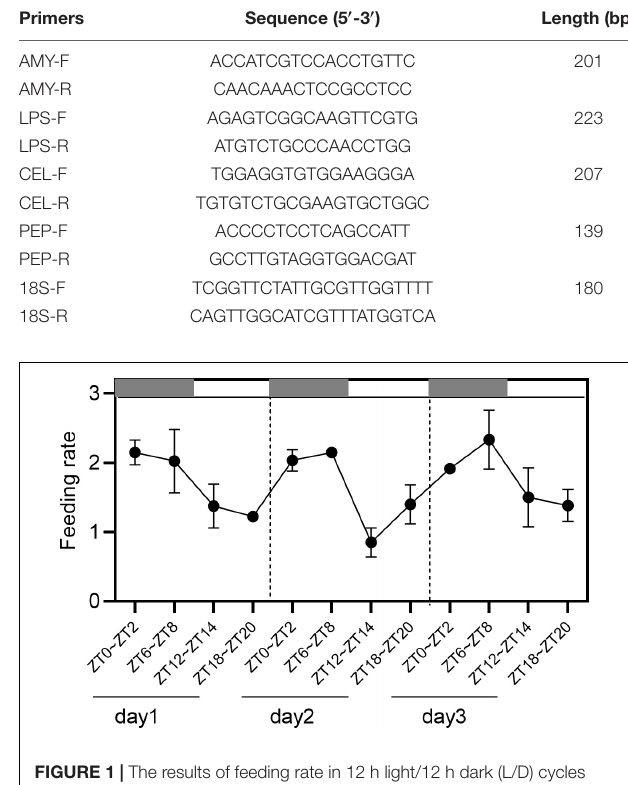
FIGURE 1 | The results of feeding rate in 12 h light/12 h dark (L/D) cycles during 3 days. Values are represented as means ± SD ( n = 3). The gray grid represents the dark time